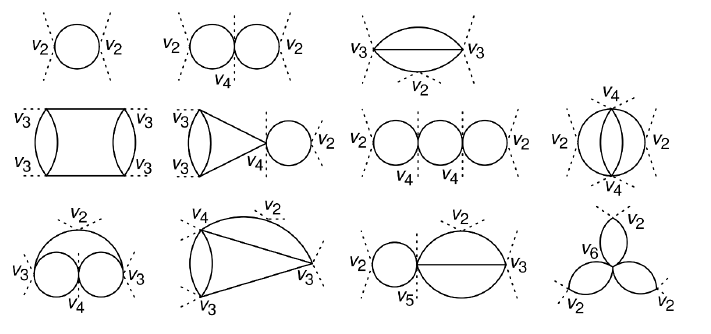
Figure 2 . The one-, two- and three-loop vacuum graphs contributing to the effective potential.